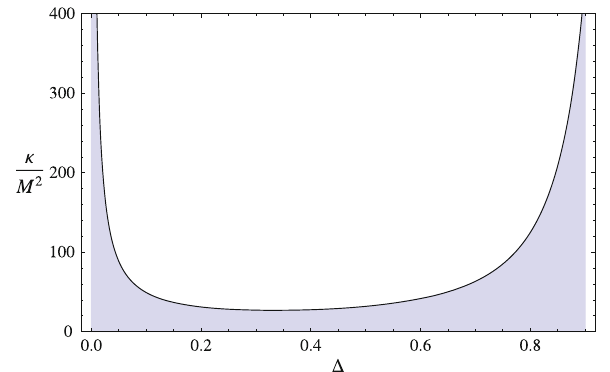
Fig. 1 The allowed value of κ/ M 2 , indicated by gray area below the curve shared feature with BV solution is that they are both not asymptotically-flat. There is a deficit solid angle (cid:19) . As η exceeds some critical value, η crit ≡ 1 / disappears and the spacetime develops conical